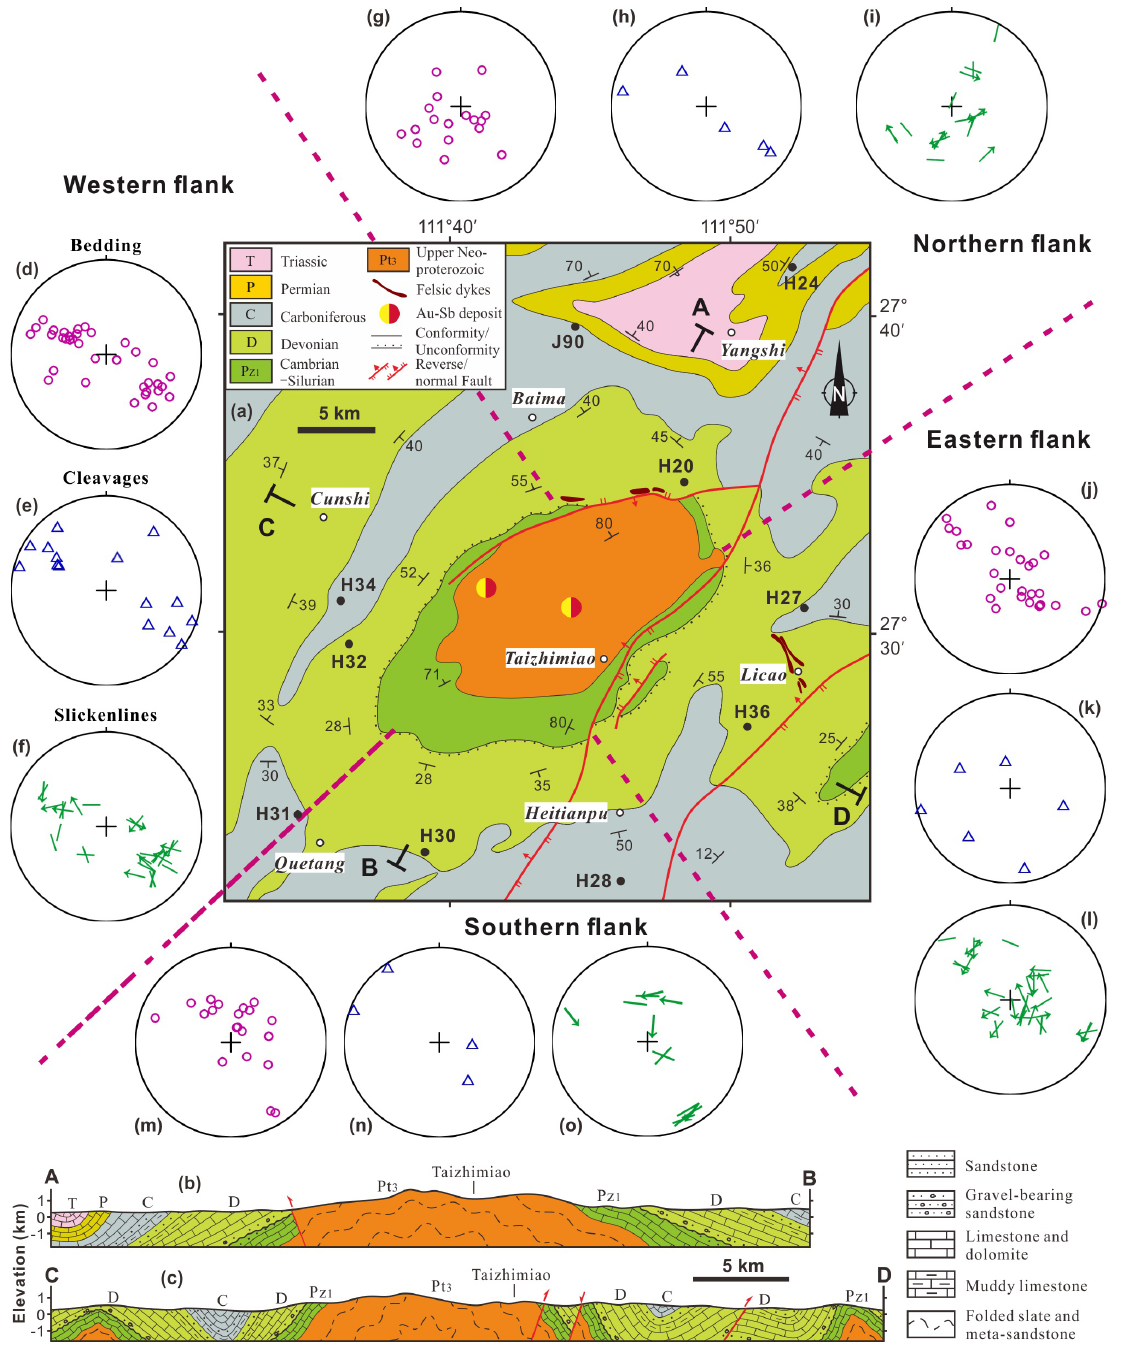
Figure 2. ( a ) Geological map and ( b–c ) transverse profile of the Longshan Dome (modified from [22]). The dome flank is divisable into four parts, eastern, southern, western and northern, for the convenience of this study. Equal-area, lower hemisphere projection ( d–o ) of beddings, slickenlines on bedding-parallel faults, and cleavages measured in the Upper Paleozoic and Triassic in each part. Each slickenline is represented by a slickenline-parallel short line at the bedding pole, with or without a directed arrow toward the relative slip movement of the overlying bed. Shown in ( a ) are locations of limestone samples collected in this study.